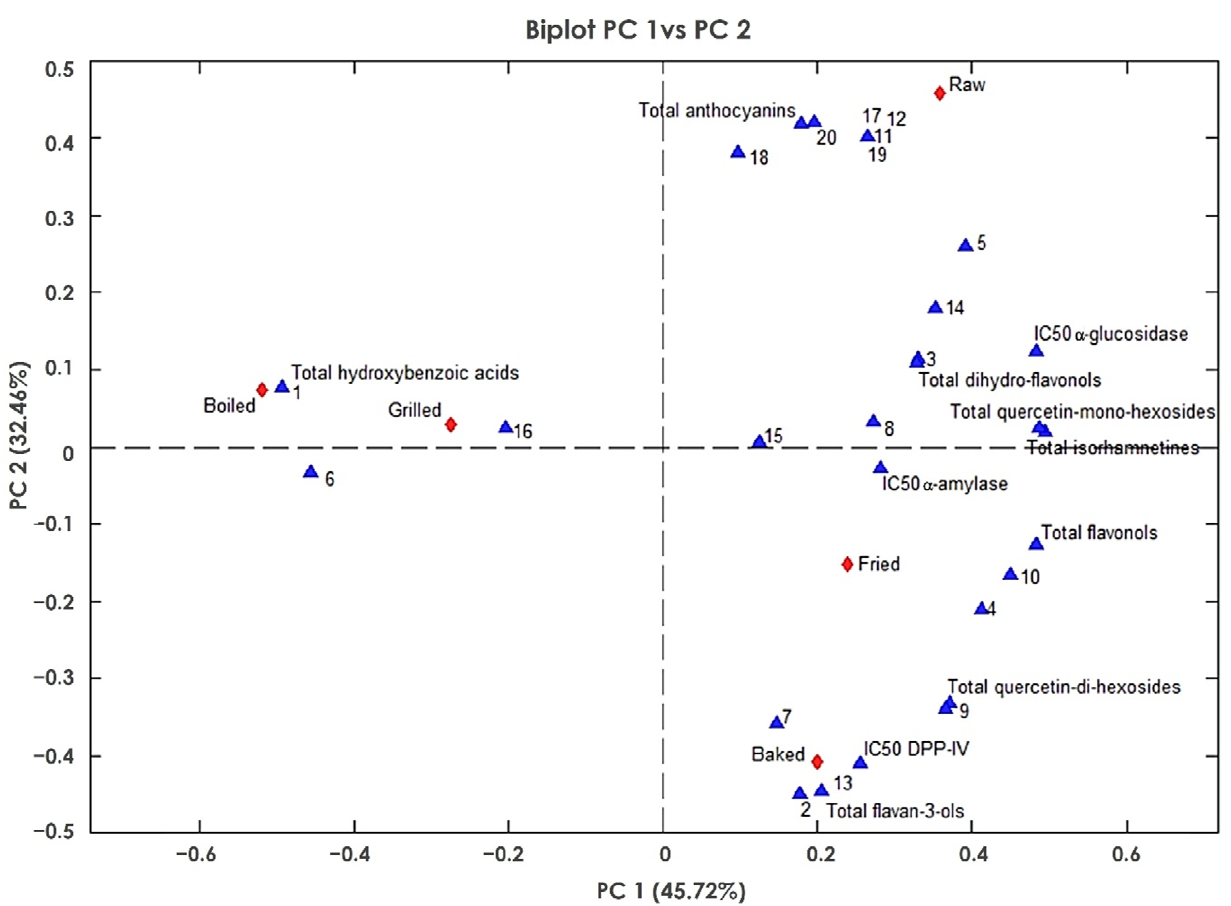
Figure 4. Principal component analysis (PCA). Loading plot of PC1 vs. PC2. The code number of compounds is reported in Table 2. The symbol ▲ identifies compounds, while the symbol ♦ identifies different cooking treatments. The individual compounds are reported with the same number as listed in Table 2.